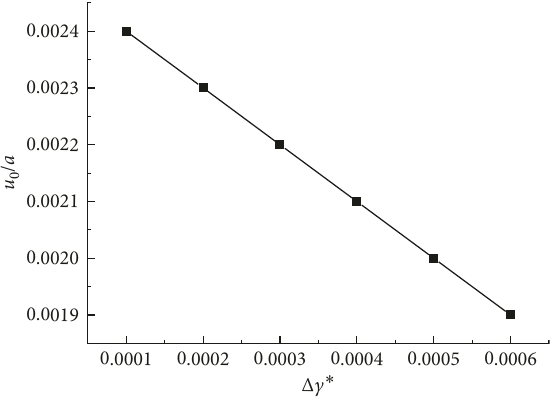
0 . 0004 0 . 0005 0 . Δ γ ∗ 0 under different